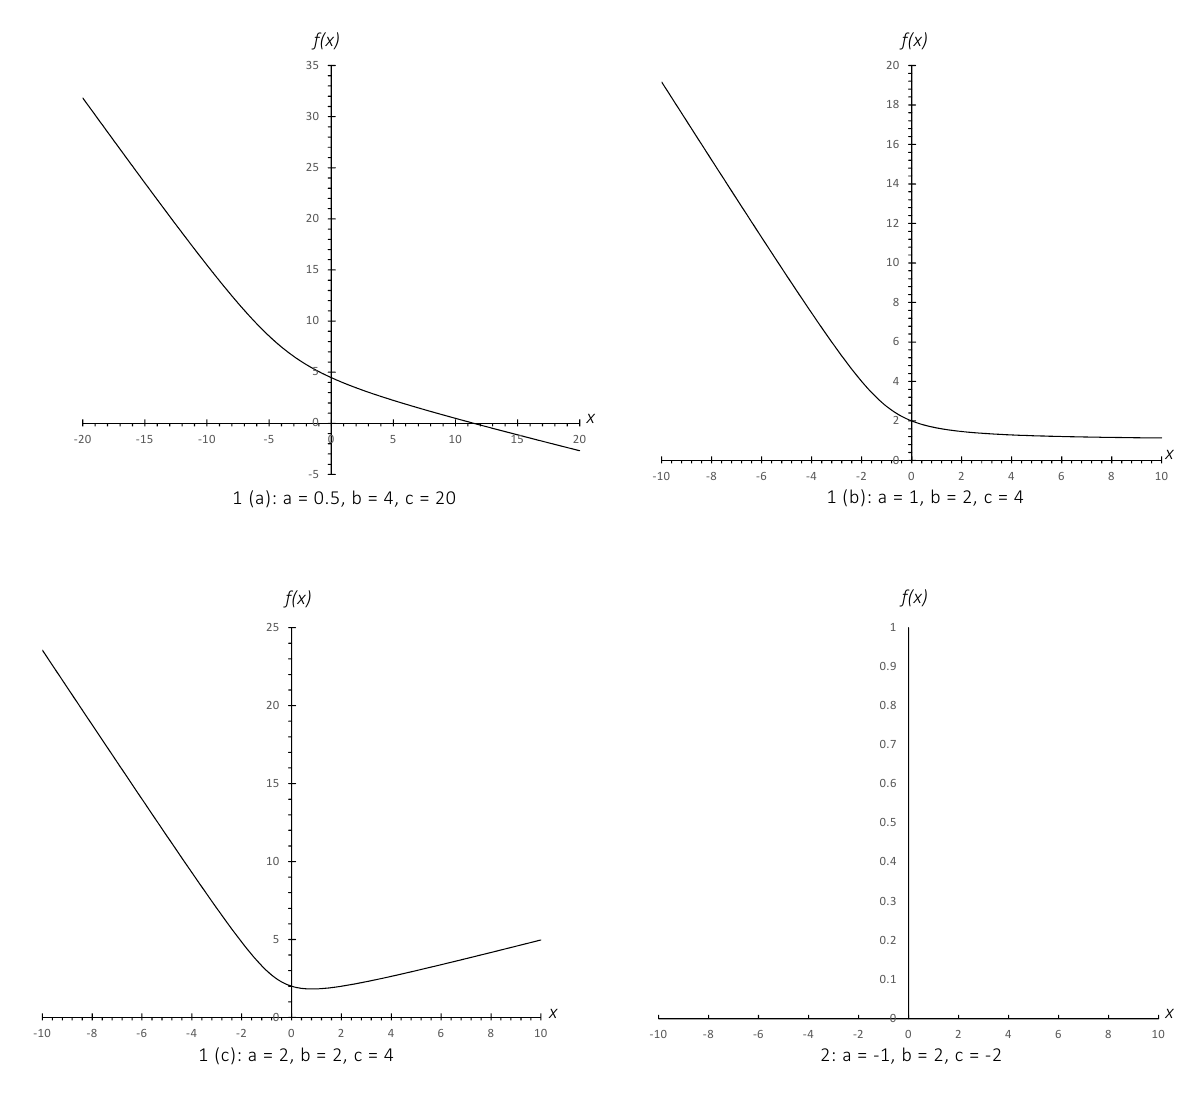
Figure A1. The graph of f ( x ) for Case 1(a) through Case 2 from Theorem